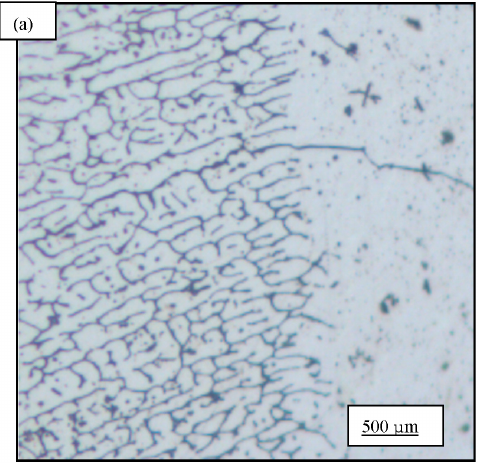
Figure 5. Cont. Figure 5. Cont